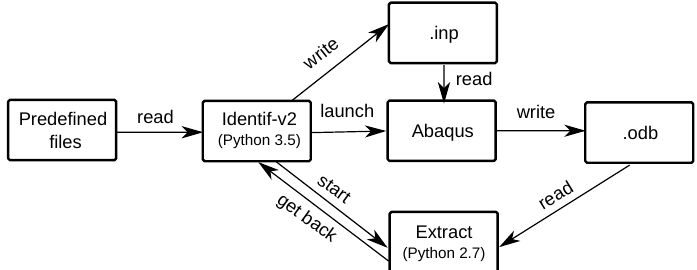
Figure 1. Flow chart of Identif-v2 .